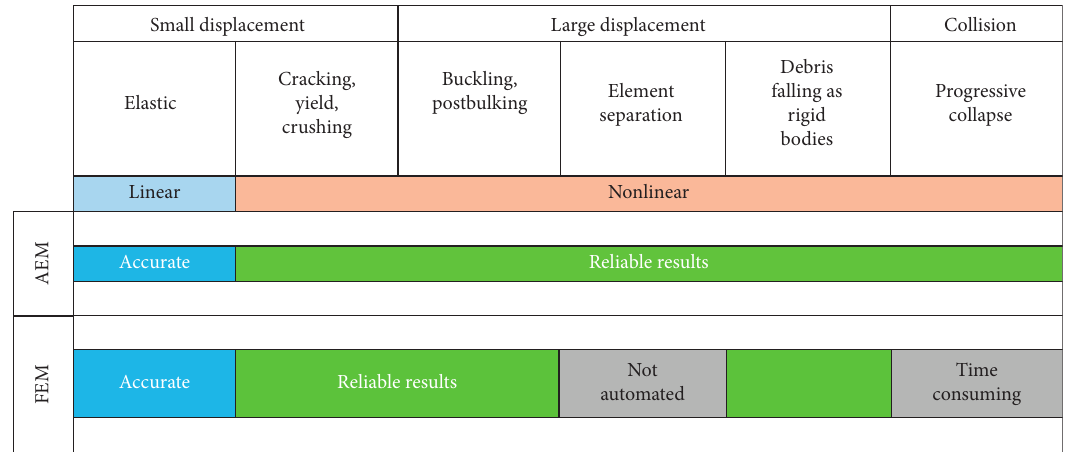
Figure 4: Scope of FEM and